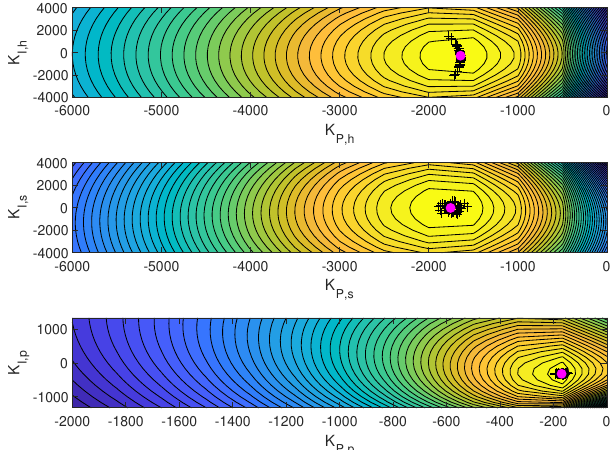
Fig. 15: Gain tunings for 20% uncertainty in the stiff- ness term for sea-state 10A.